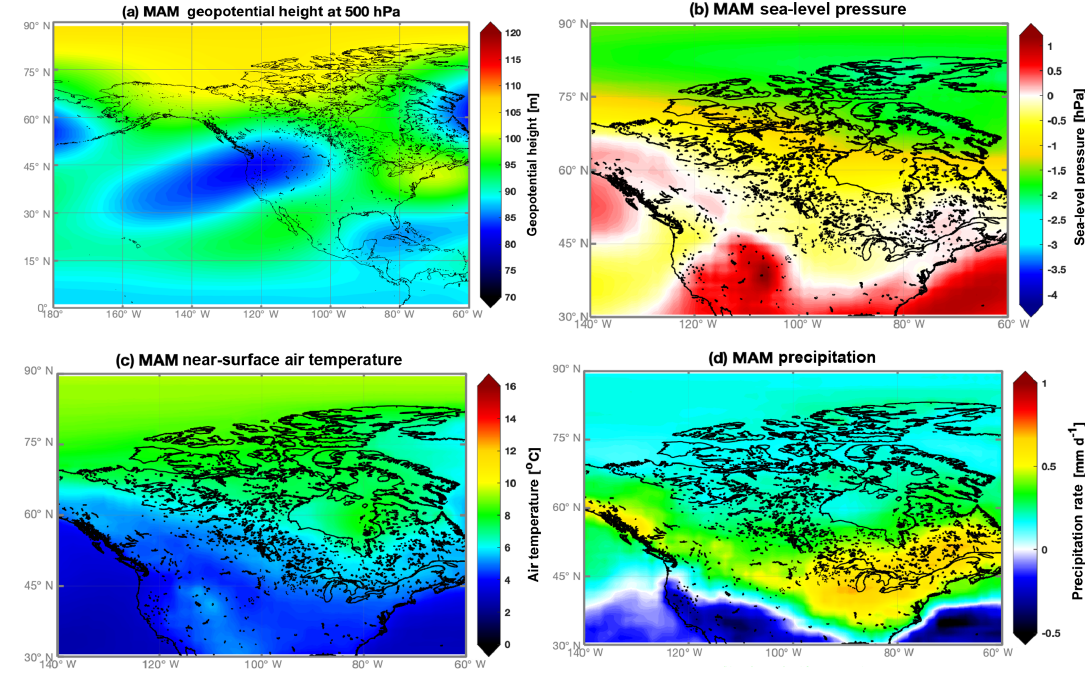
Figure 5. As in Fig. 2 but for spring (MAM).